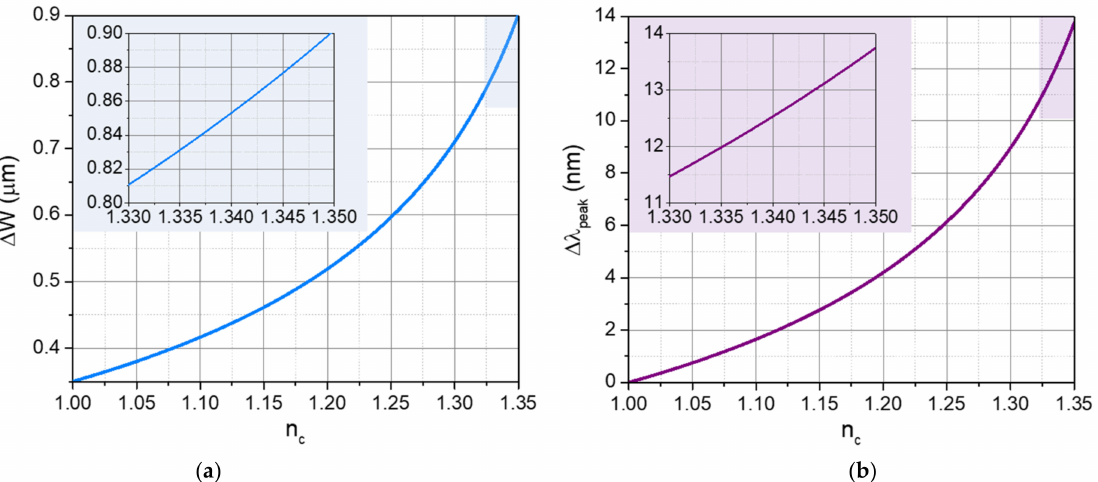
Figure 2. ( a ) Evanescent penetration beyond the geometrical diameter of the NC-MMF (second term in Equation (2), labeled as ∆ W ) as a function of n c . ( b ) Wavelength shift with respect to a baseline condition where the NC-MMF is surrounded by air as a function of n c . The insets show in more detail the range of interest for water–milk mixtures (see text for